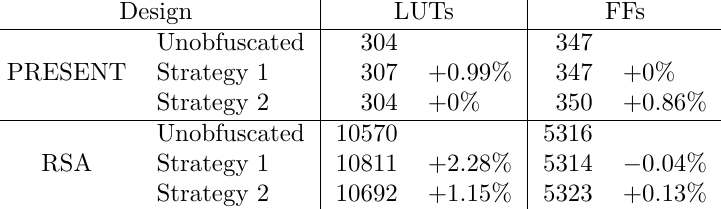
Table 2: Area comparison of our three case studies. Percentual changes refer to the unobfuscated